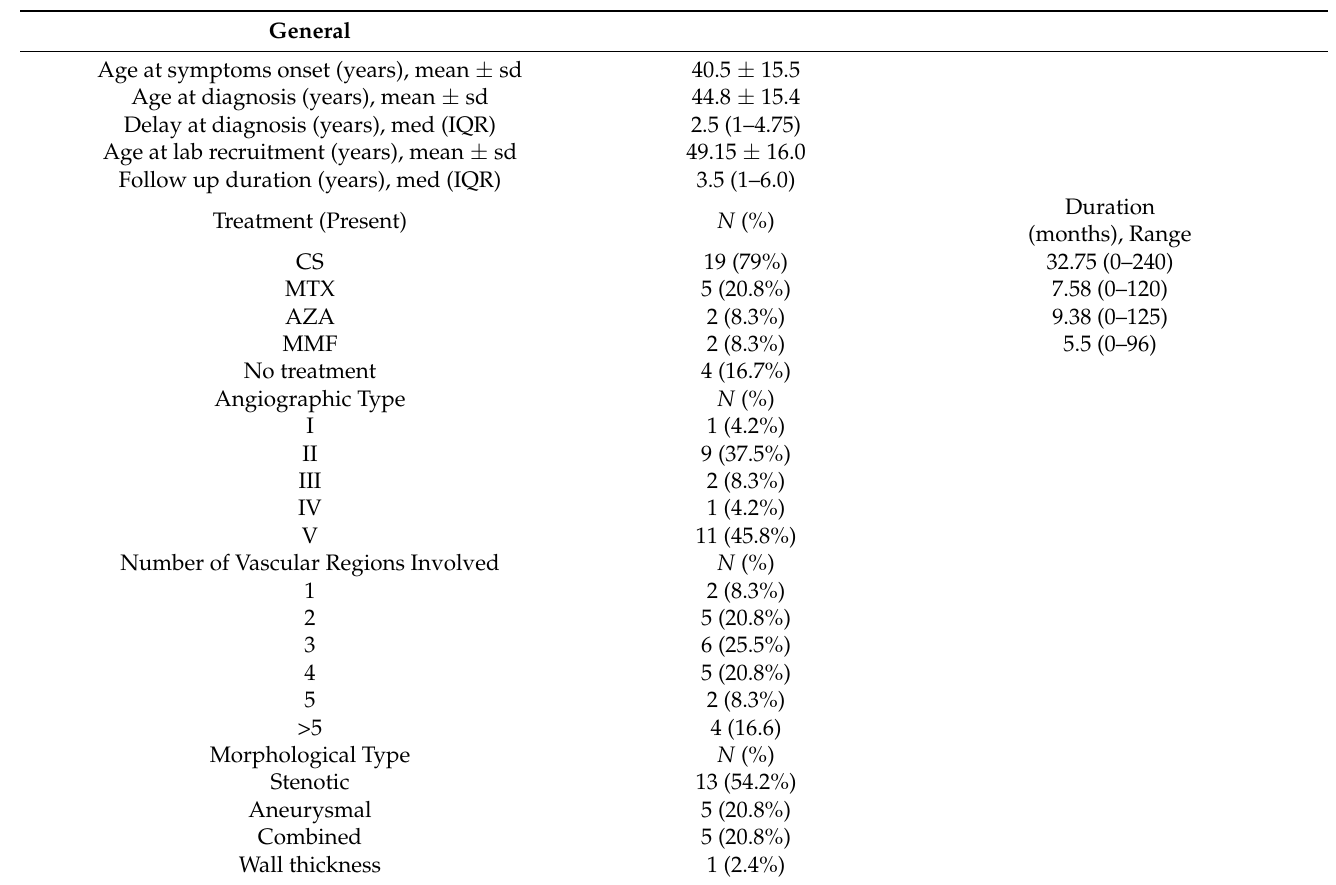
Table 1. Demographic and clinical patients’